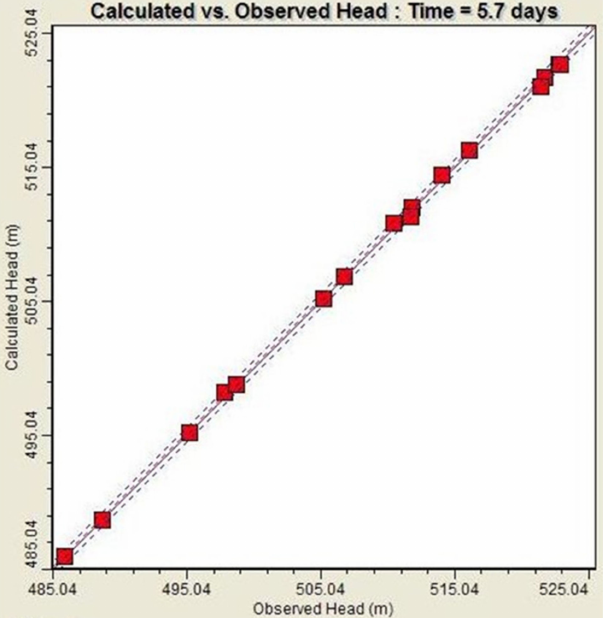
Figure 6. Comparison between model-calculated and measured averaged groundwater levels in the observation wells.